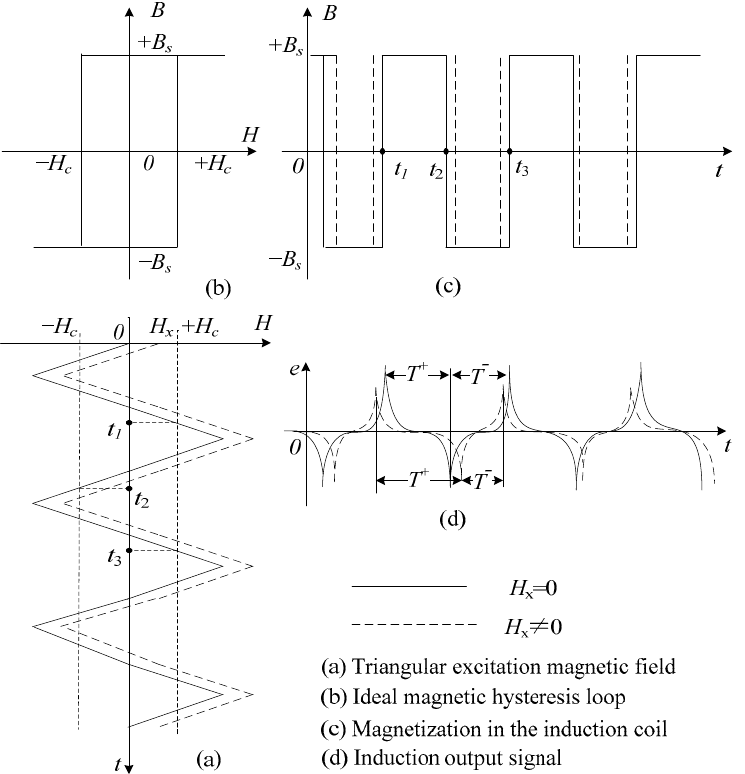
Figure 1. Schematic diagram of residence times difference (RTD)-fluxgate working principle.